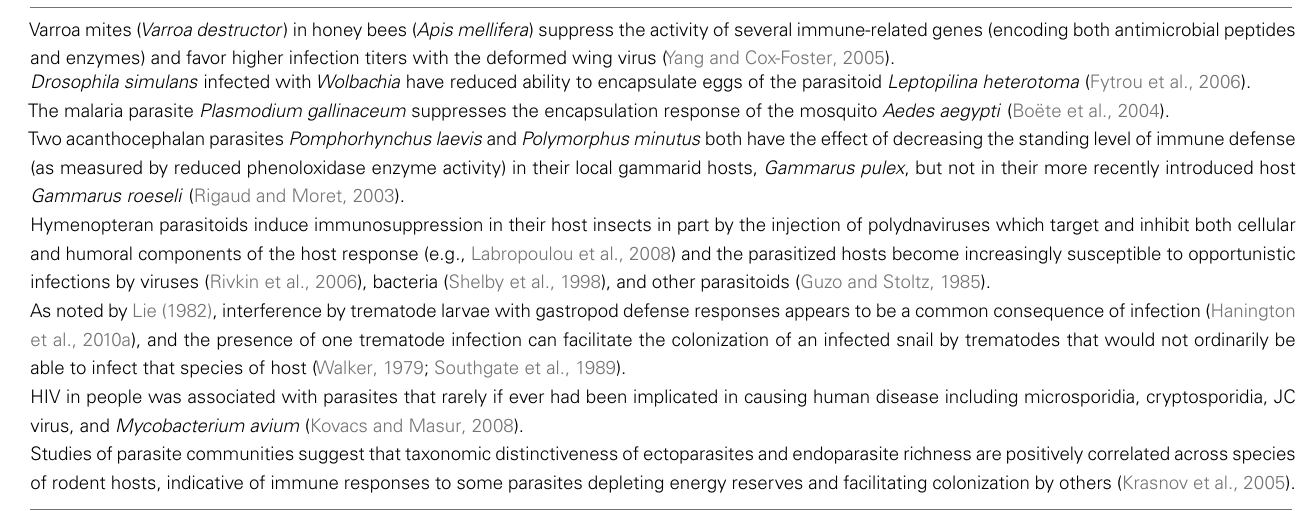
Table 6 | Examples of immunosuppression by one parasite that could favor acquisition of new parasites, and potentially an eventual speciation